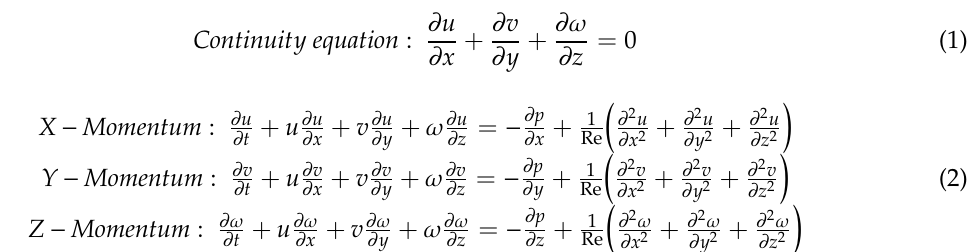
Table 3. Blade gap and overlap ratio for main rotor types considered for analysis.